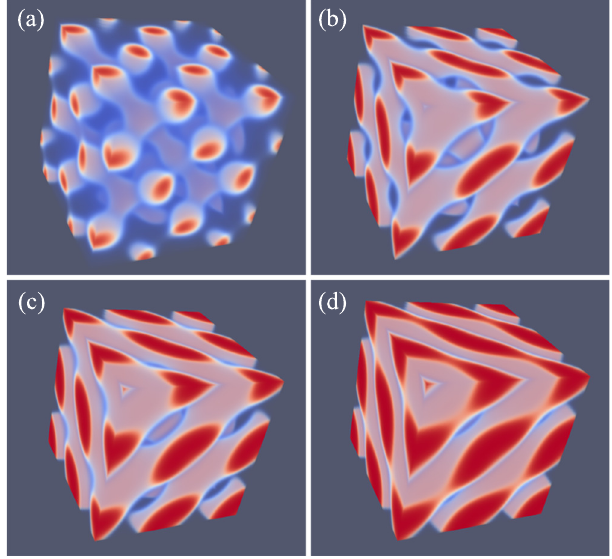
Figure 11. Equal density contour plots for the HPL phase for N = 300, L = 43 and χ N = 30. ( a – d ) correspond to f values of 0.19, 0.30, 0.37 and 0.50, respectively. Unit cells were doubled in each direction. Color coding as in Figure 3. Note that we did not optimize the box size in this case.